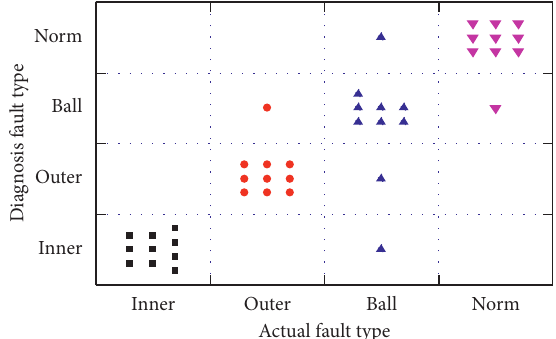
Figure 18: Automatic diagnosis results of multiple signals.